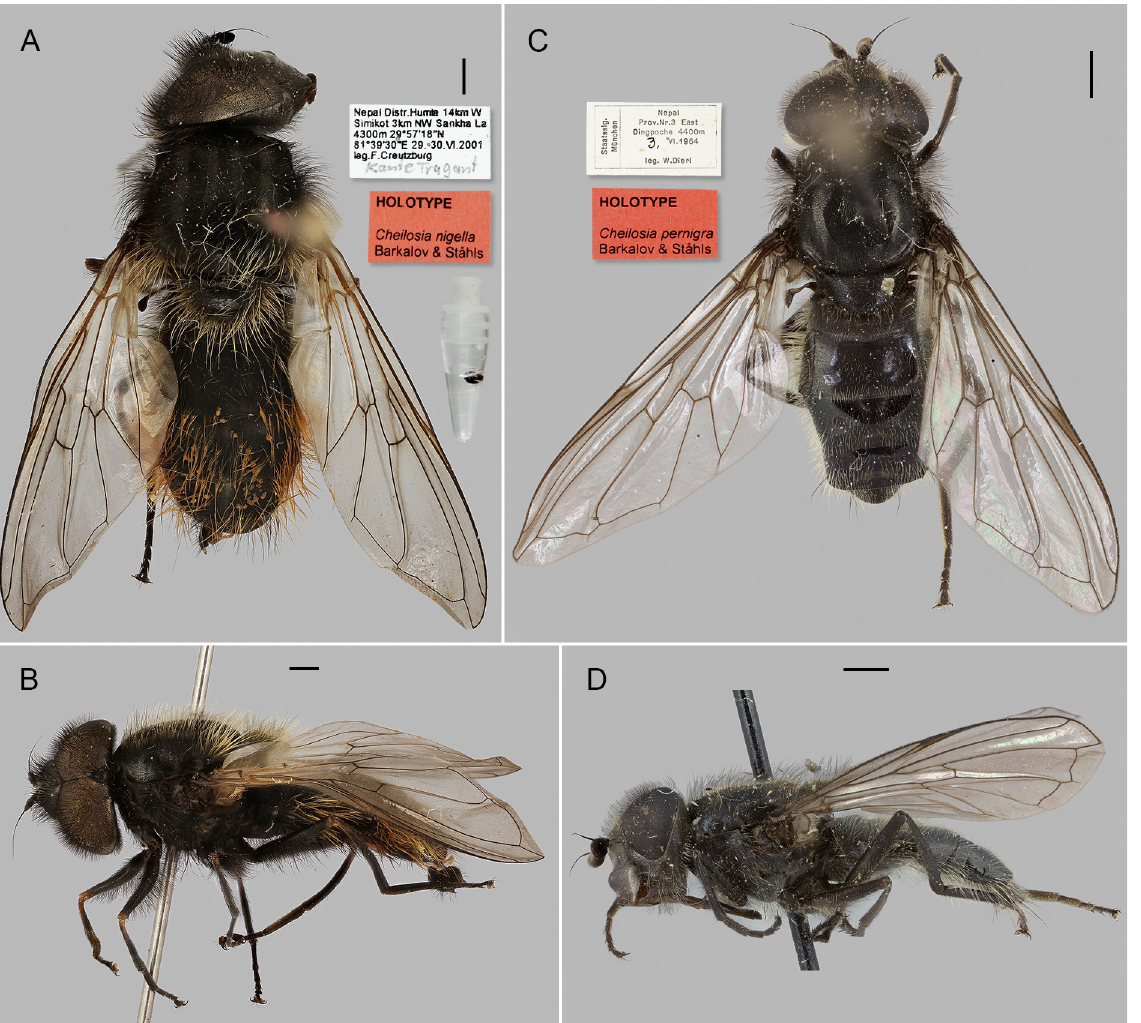
Fig. 46. A–B . Cheilosia ( Montanocheila ) nigella sp. nov., holotype, ♂ (NME); dorsal and lateral views. – C–D . Cheilosia ( Montanocheila ) pernigra sp. nov., holotype ♀ (ZSMC); dorsal and lateral views. Photo: Pekka Malinen, FMNH Luomus. Scale bars = 1